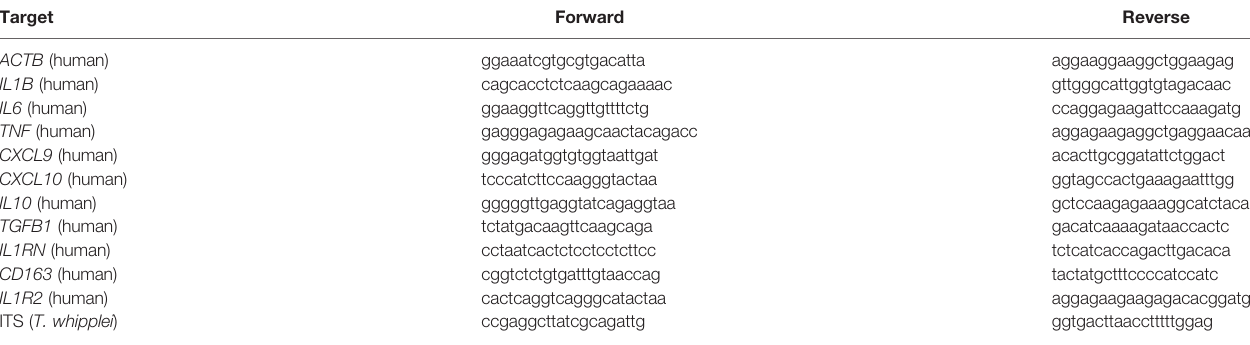
TABLE 2 | Primers used in this study.